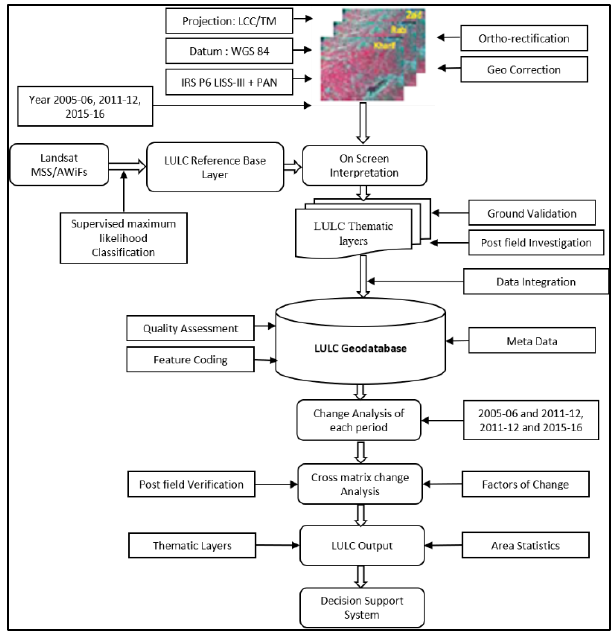
Figure 2: Flow chart showing the